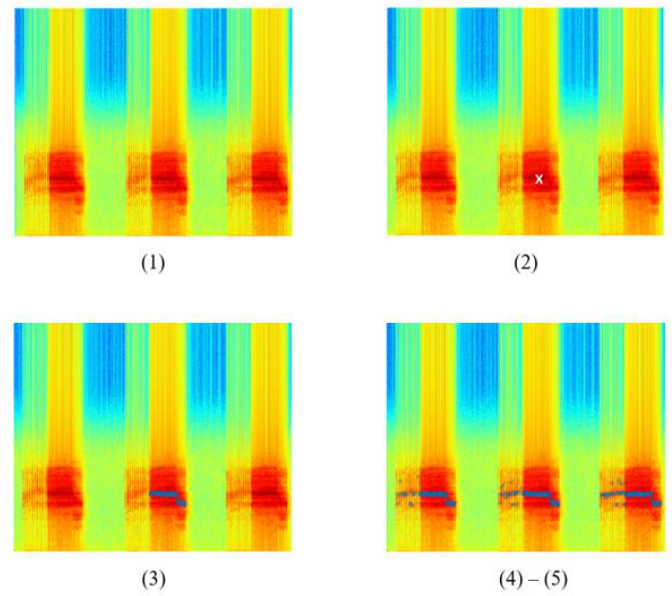
Figure 7. Output of steps involved in the Härmä syllable segmentation algorithm.